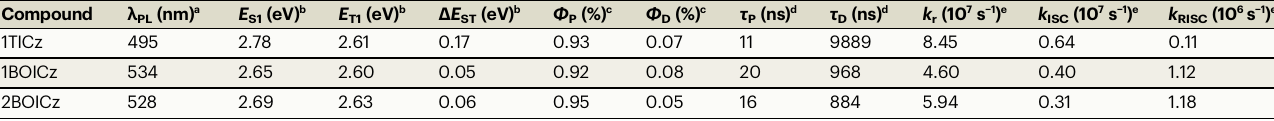
Table 1 | Photophysical properties of 1TICz, 1BOICz, and 2BOICz in doped fi lms